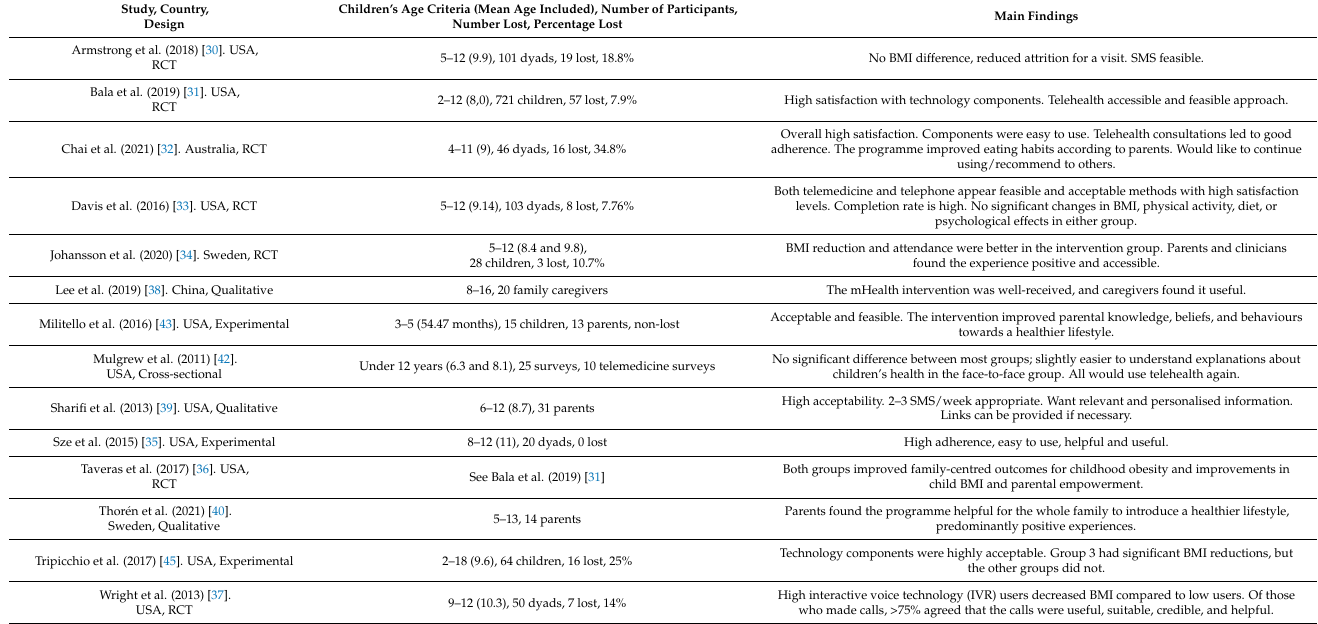
Table 1. Included studies part 1, Demographics and